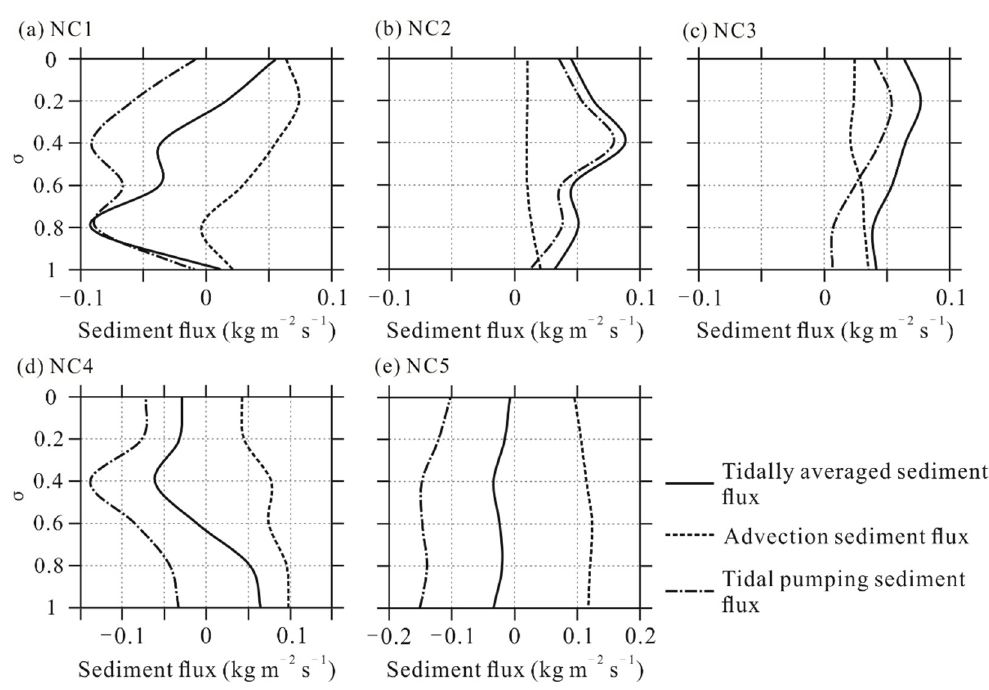
Figure 11. Vertical profiles of the longitudinal tidally averaged sediment flux, < uc > (kg m − 2 s − 1 ), ad- vection sediment flux, 𝑢 (cid:2868) 𝑐 (cid:2868) (kg m − 2 s − 1 ), and tidal pumping sediment flux, < 𝑢 (cid:3047) 𝑐 (cid:3047) > (kg m − 2 s − 1 ), over advection sediment flux, u 0 c 0 (kg m − 2 s − 1 ), and tidal pumping sediment flux, < u t c t > (kg m − 2 s − 1 a flood–ebb tidal cycle at NC1 to NC5 stations ( a – e ). Here, 𝜎 is relative depth, 𝜎 = −𝑧/ℎ ( 𝜎 = 0 is the surface and 𝜎 = 1 the bottom).